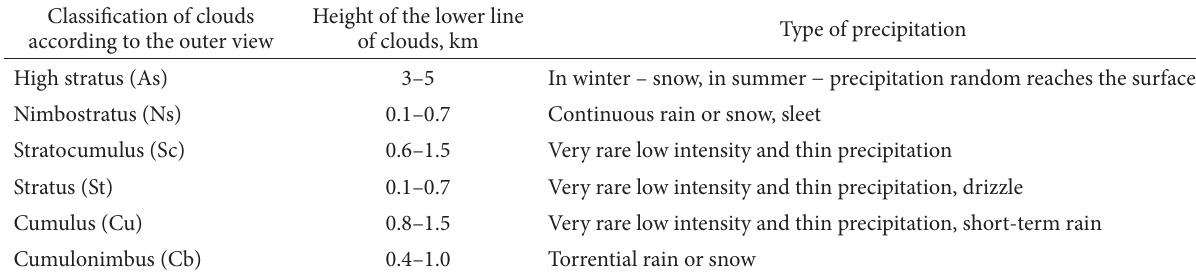
Table 2. The values of Roughness Coefficient (Lithuanian Hydrometeorological Service) Water surface Fully open location with even surface, e.g. roads, airports, pastures, etc.